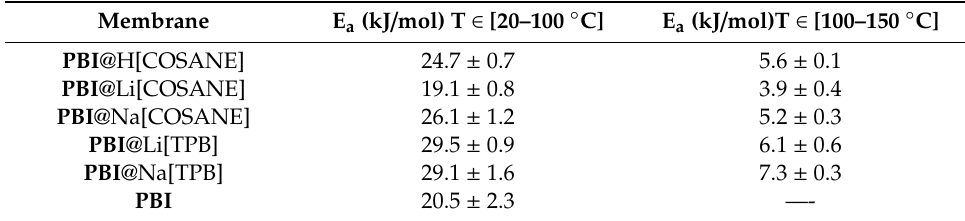
Table 8. Activation energy values for PBI, PBI@M[COSANE], and PBI@M[TPB] membranes.